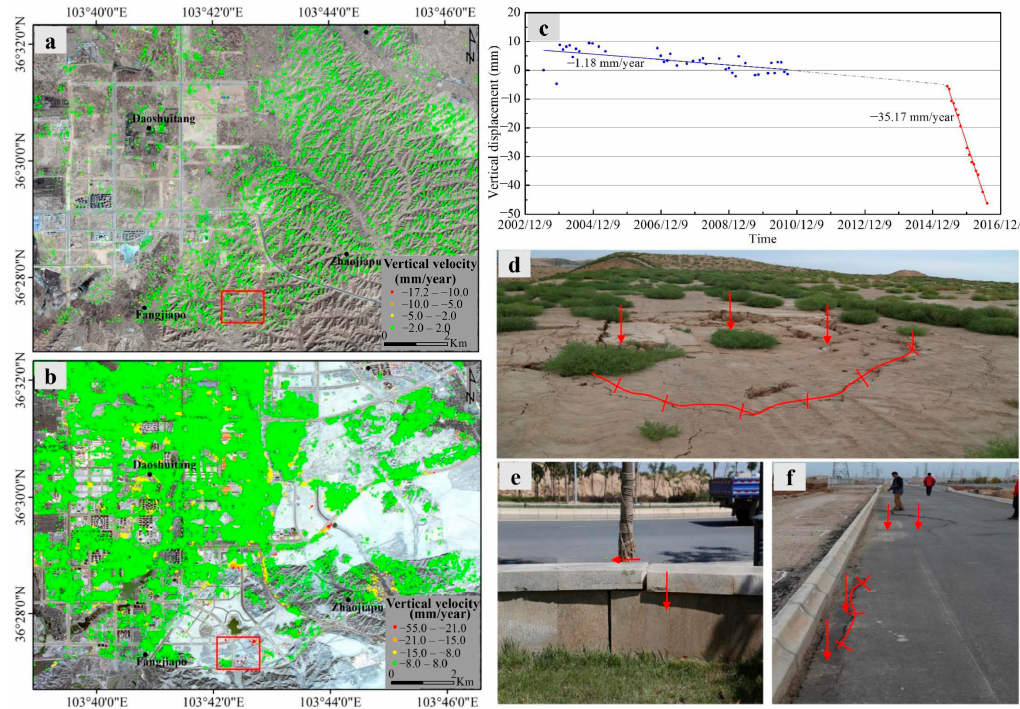
Figure 5. Typical subsidence observed in the land creation area located in the Southern sector: ( a ) Average 2003–2010 velocity map; the PSs were superimposed on the Google Earth image obtained on 3 March 2013. ( b ) Average 2015–2016 velocity map; the CTs were superimposed on the GF-1 satellite image acquired on 17 October 2016. Red rectangles in ( a , b ) indicate the location of the PSs and Coherent Targets selected, respectively. ( c ) Vertical displacement time-series and corresponding linear rates of subsidence. Envisat (blue) and Sentinel-1A (red) time series are shown. The gap between 2011 and 2014 was filled by a prediction trendline (grey dashed line in ( c )). Images of: ( d ) ground fissures and sinkhole; ( e ) wall cracks; and ( f ) road settlement.